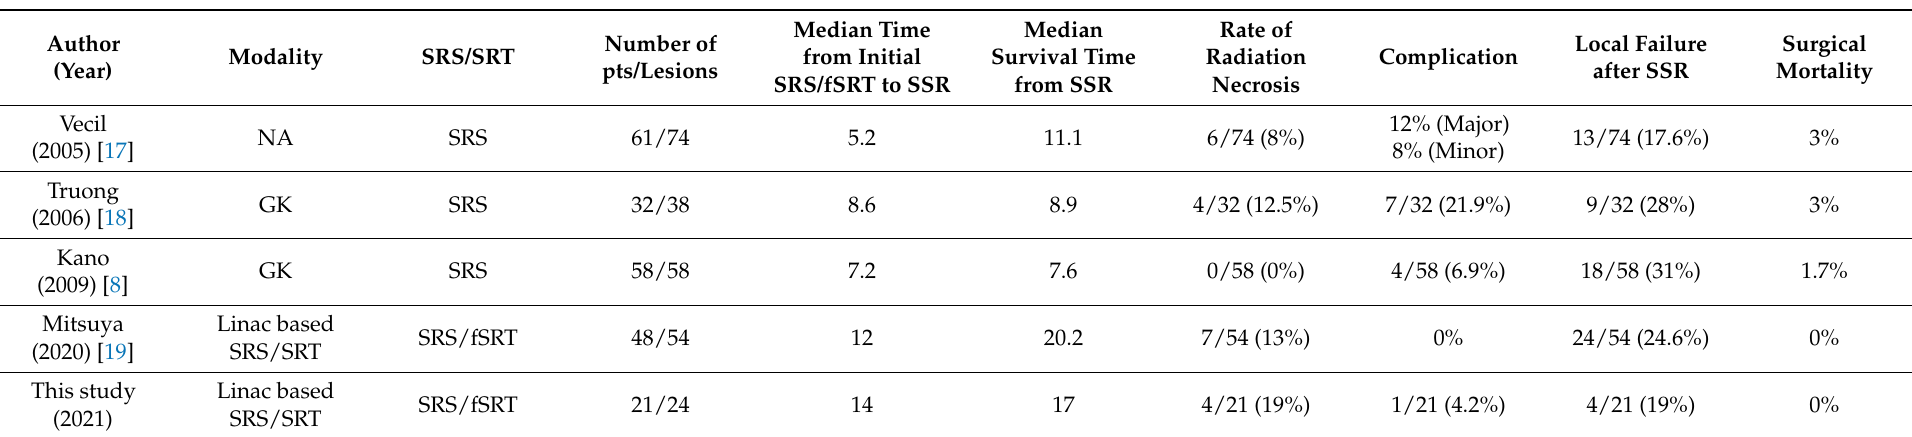
Table 3. Summary of SSR for recurrent brain metastasis after